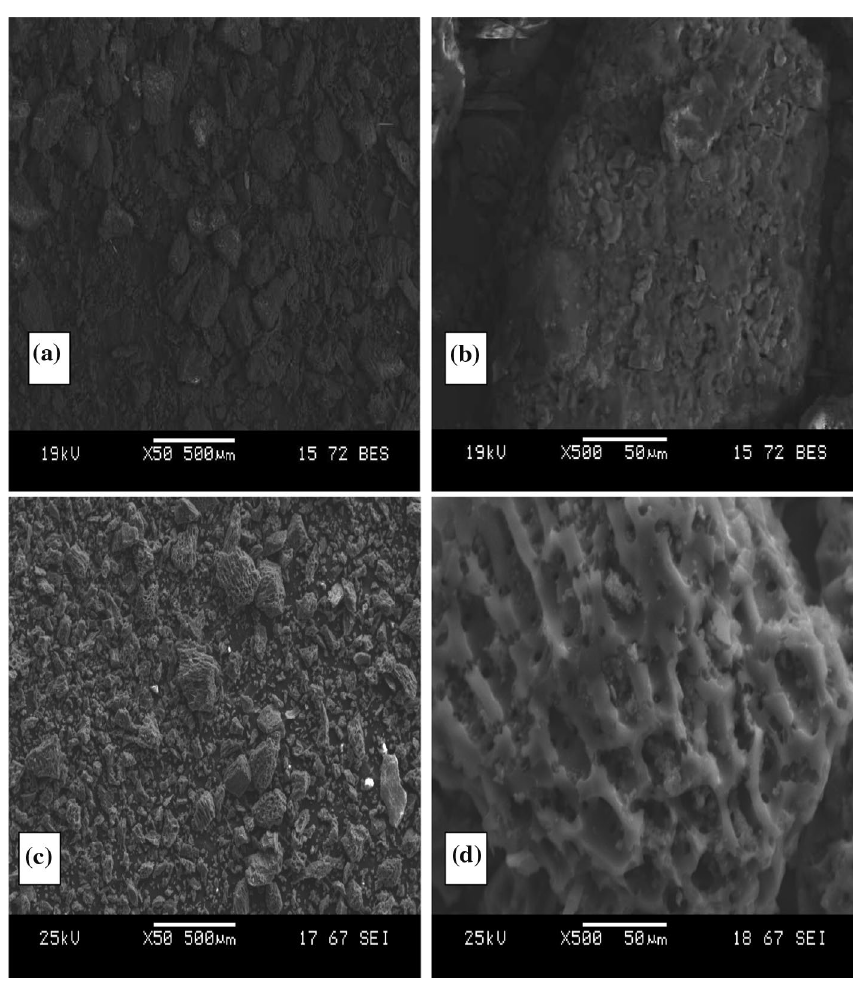
Fig. 2 SEM micrographs of